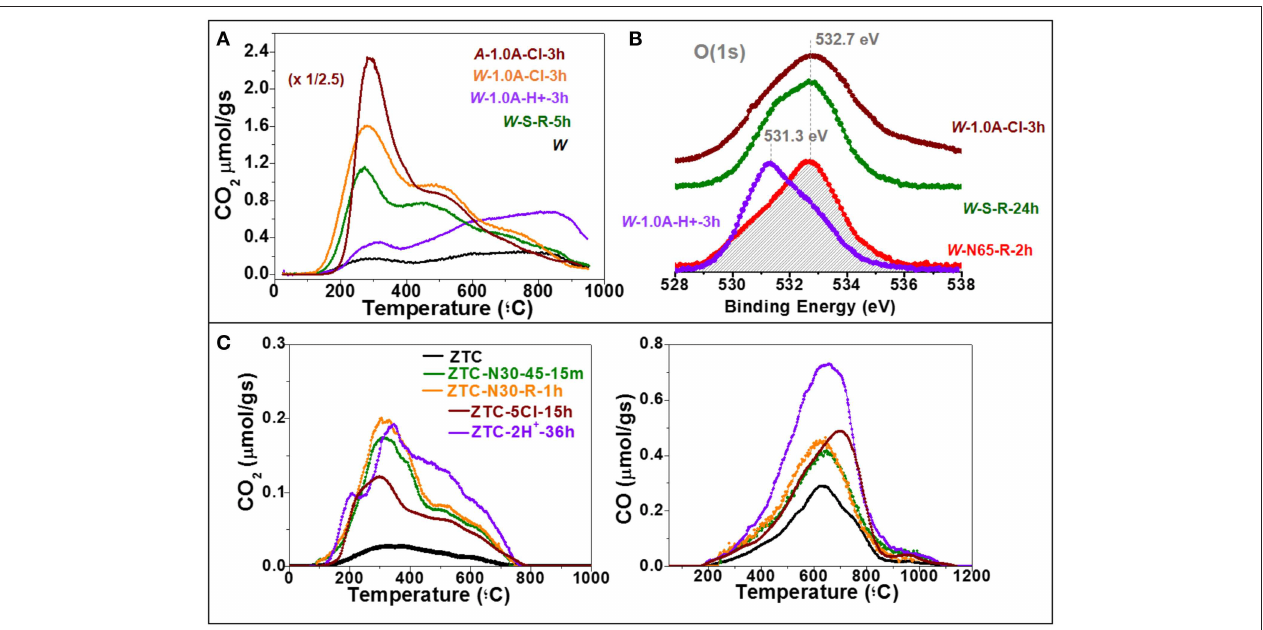
FIGURE 6 | (A) CO 2 evolution from TPD experiments for the original and the chemically- and anodically-treated W and A ; (B) O(1s) XPS spectra of the W samples oxidized by different chemical and electrochemical methods; (C) CO 2 and CO evolution from TPD experiments for the original and the chemically- and anodically-oxidized ZTC